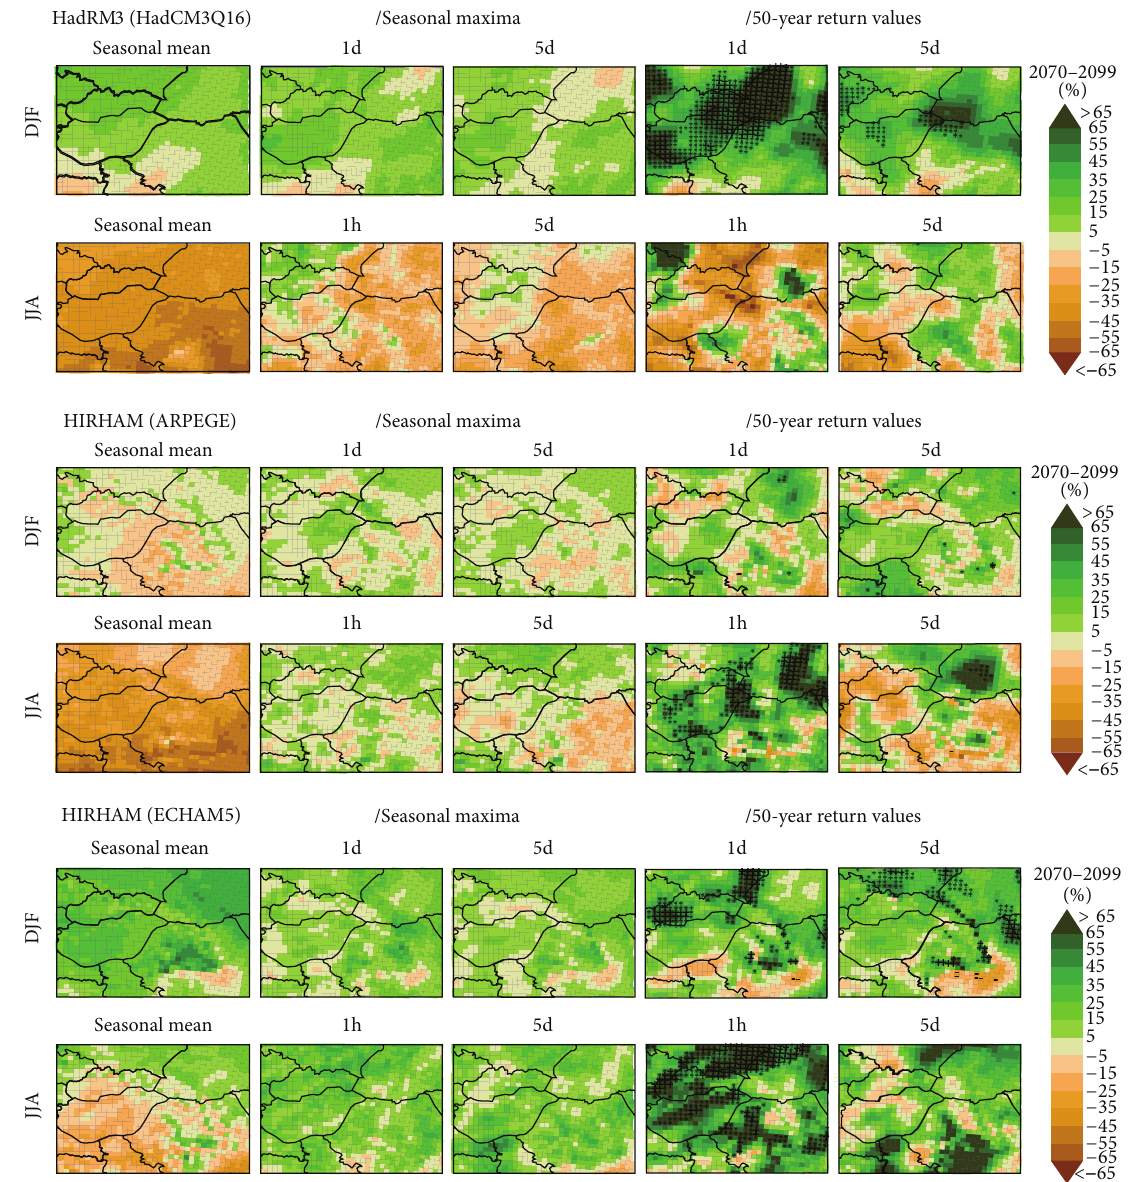
Figure 2: Projected relative changes (in %) for the late 21st century (2070–2099) in comparison with the control period (1961–1990) of mean seasonal precipitation, mean seasonal maxima, and 50-year return values of 1-hour/1-day and 5-day precipitation assessed by the pooling (ROI) approach, for 3 selected RCMs. Large (small) “+/ − ” signs denote grid boxes where the estimated 90% (80%) CIs of the 50-year return values do not overlap. For further details and explanation, see